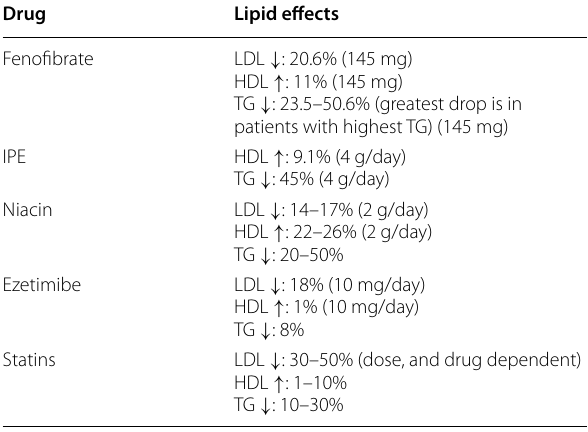
Table 7 Lipid effects of different drugs: Drug Lipid effects